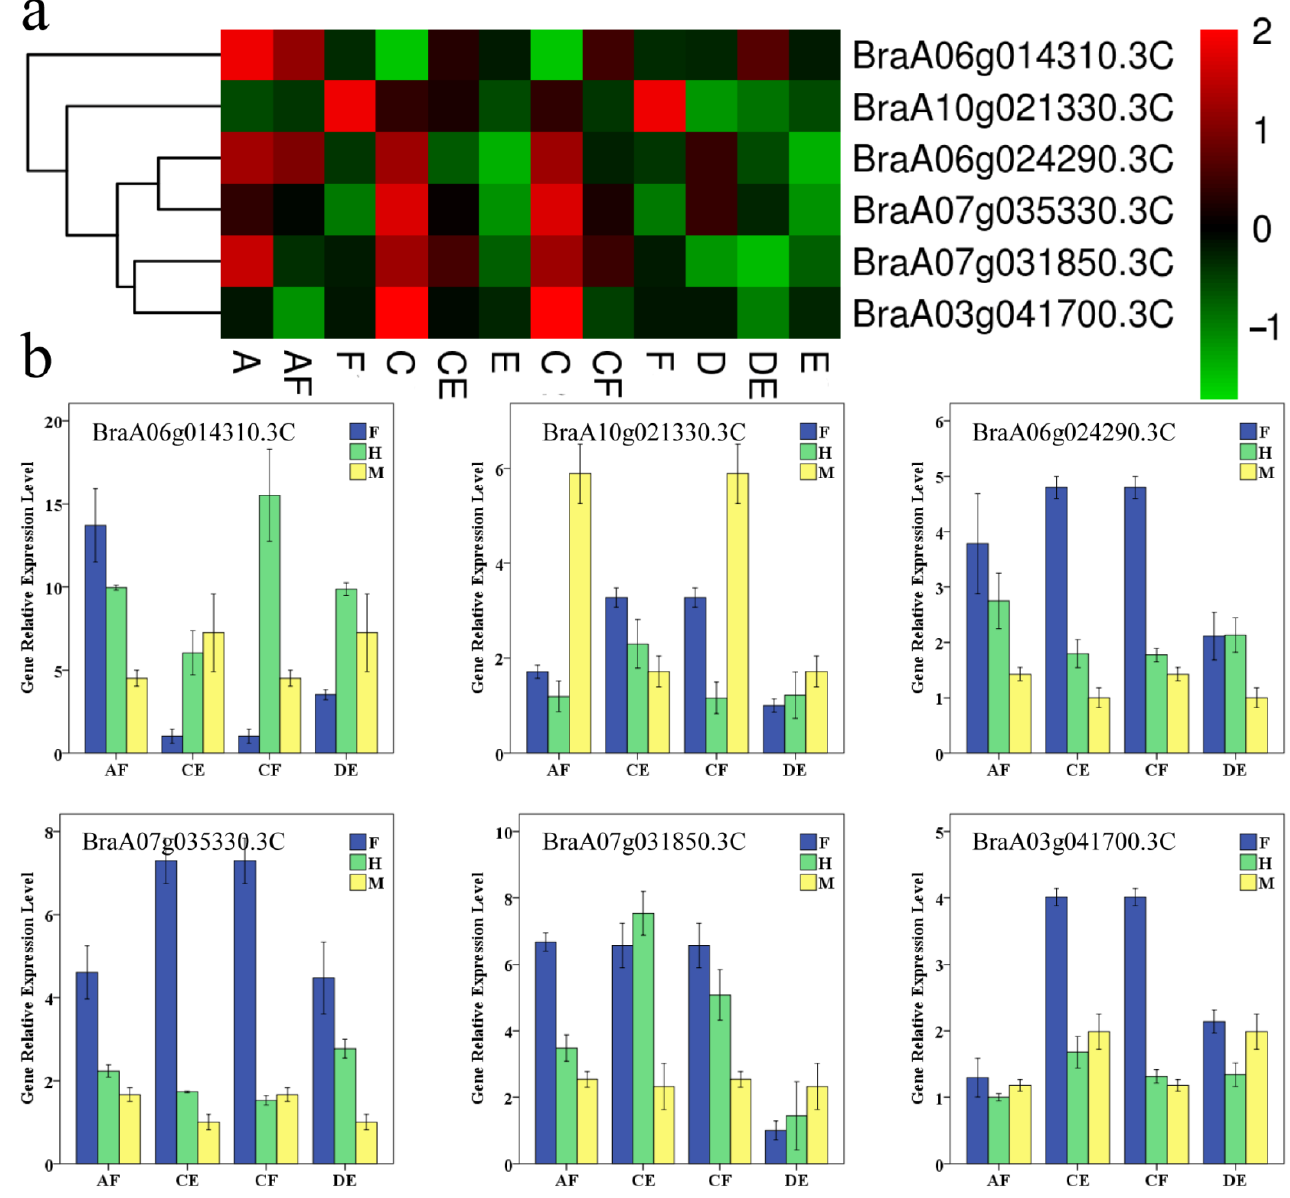
Figure 7. Gene expression of different AS genes involved in amino acid metabolism. ( a ) using RNA-seq. data. ( b ) using qPCR data. Bars represent mean ± SE of triplicate tests. F: female parent; M: male parent; H: hybrid.